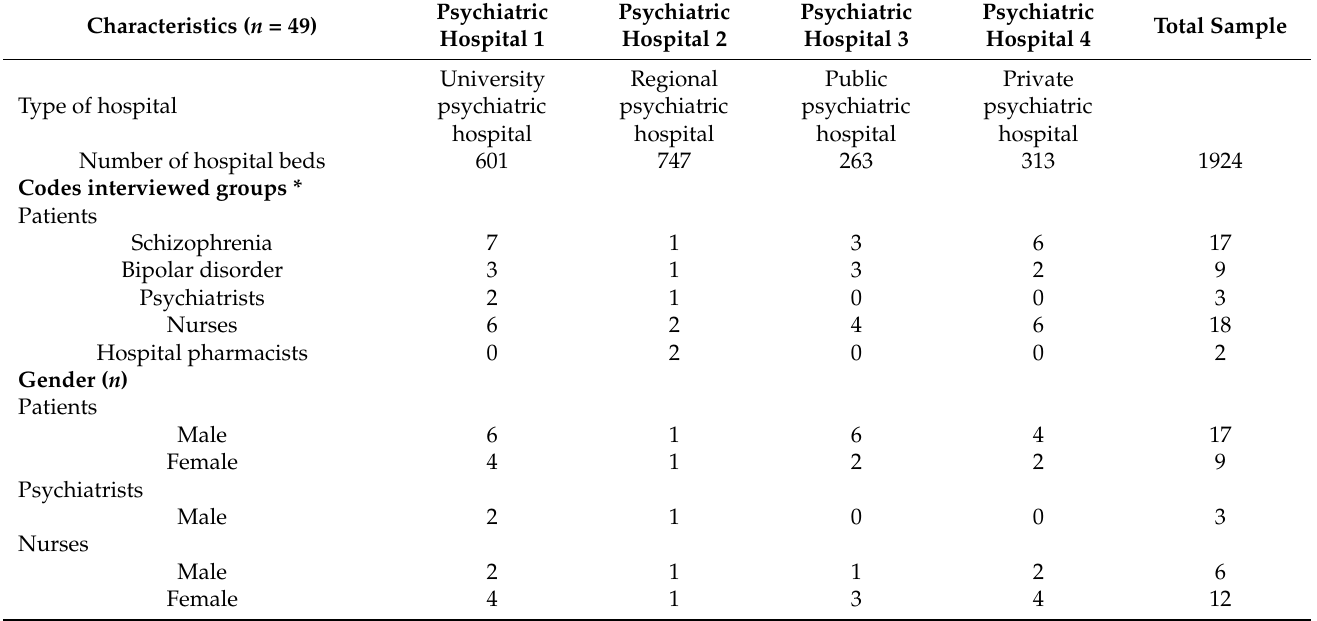
Table 1. Demographic characteristics of the interviewed participants per